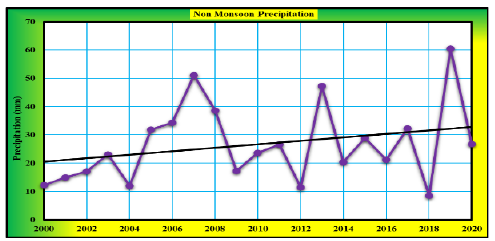
Figure 6: Monsoon Rainfall Deviation in Ghotki district 2000-2020